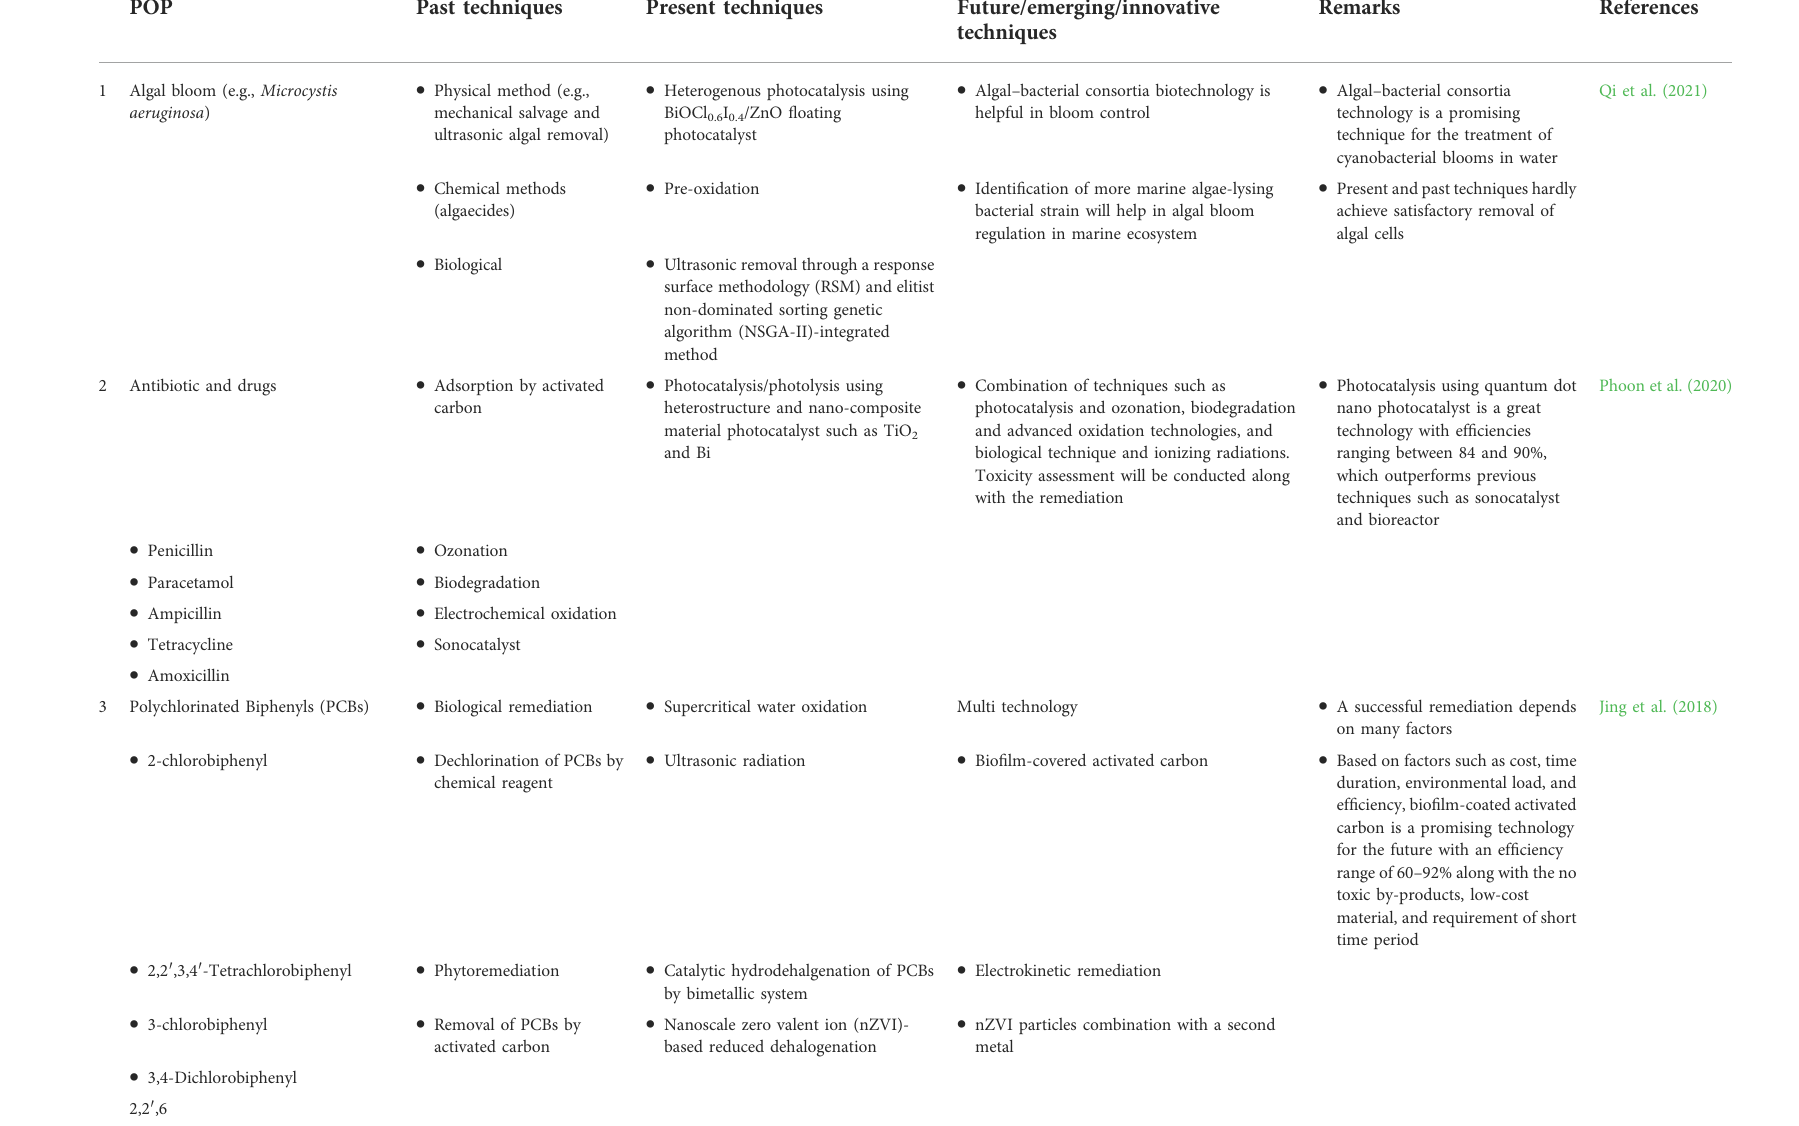
TABLE 1 List of strategies used for the remediation of persistent organic pollutants, covering past, present, and future/emerging/innovative techniques.